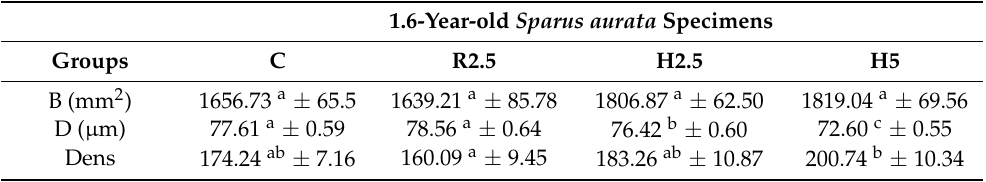
Table 3. Muscle growth parameters of adult specimens of Sparus aurata .